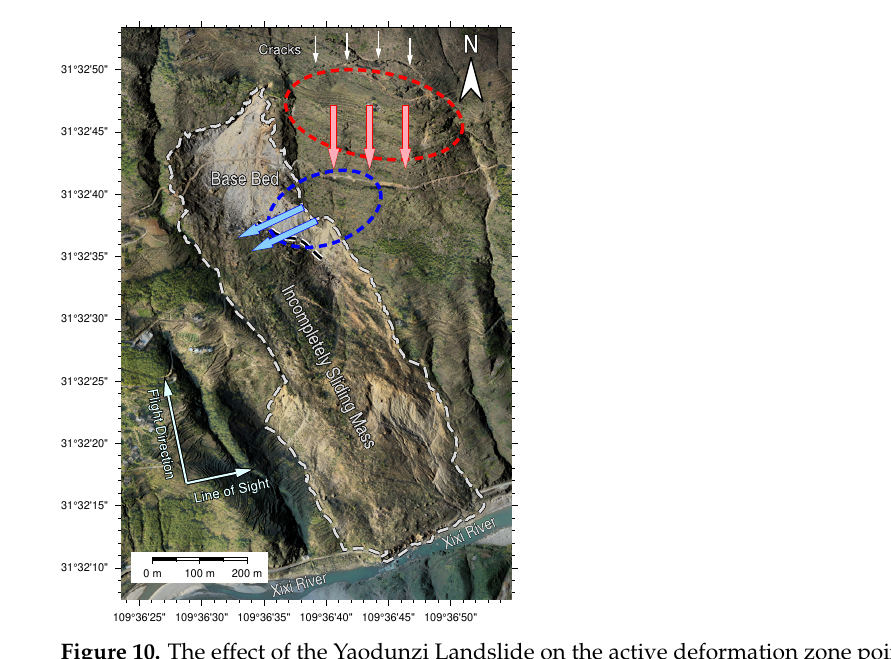
Figure 10. The effect of the Yaodunzi Landslide on the active deformation zone point 2. The arrow indicates the force induced by the Yaodunzi landslide. The red and blue arrows represent the indirect force and direct force, respectively, to the active deformation zone point 2. The white arrows show the location of the cracks at the rear edge of Yaodunzi